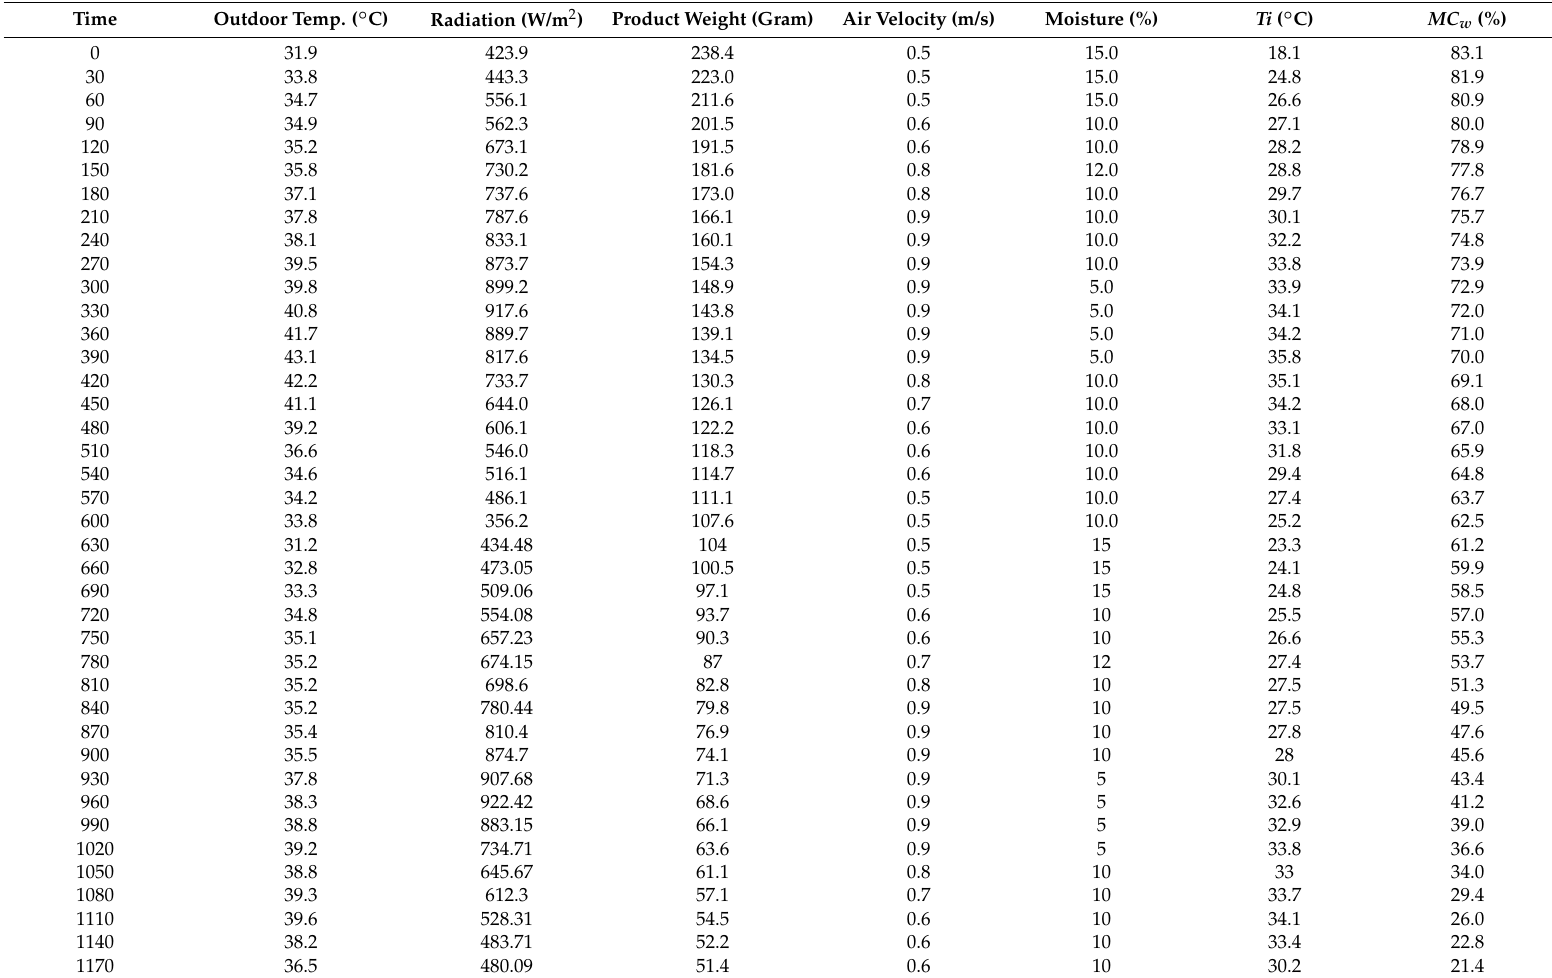
Table 4. Under the sun drying experiment